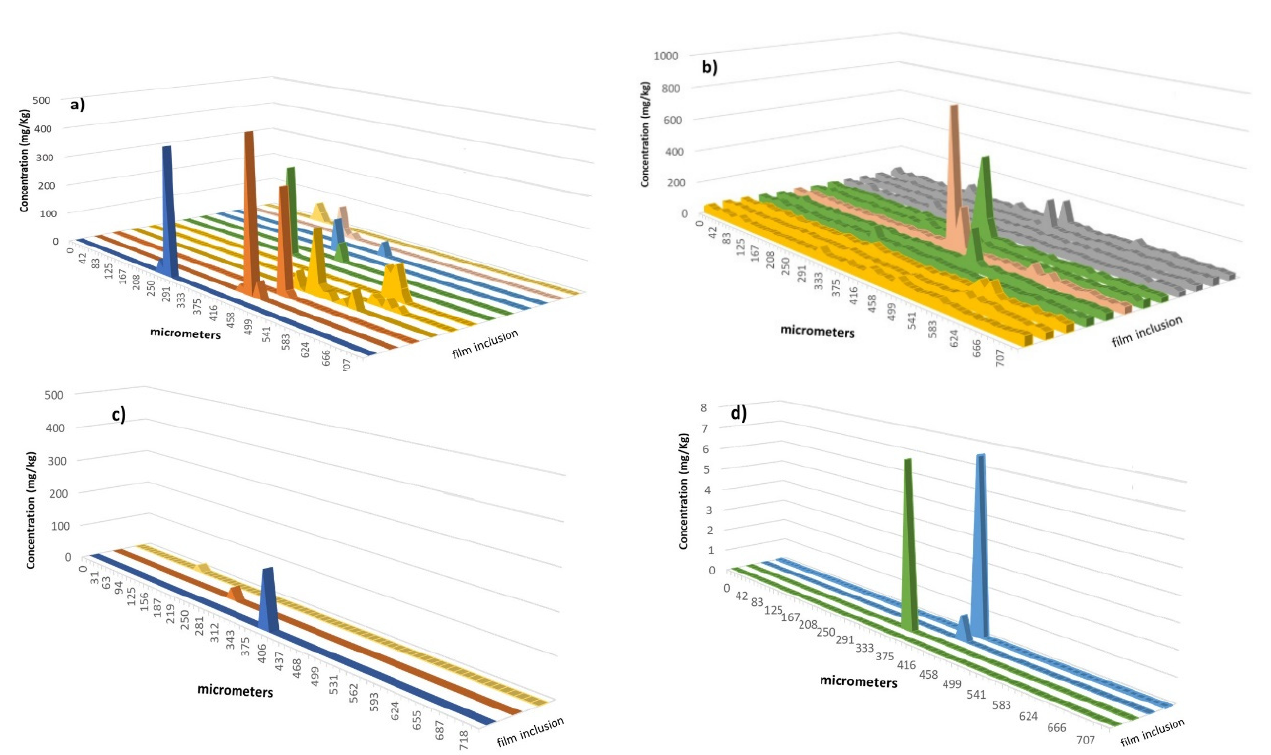
Figure 6. Concentration profiles of ( a ) Al, ( b ) Mg, ( c ) Ti, and ( d ) Cr along the scan line used to ablate the defects in film # 1. Only the inclusions yielding ICP-MS signals for the monitored elements are included.